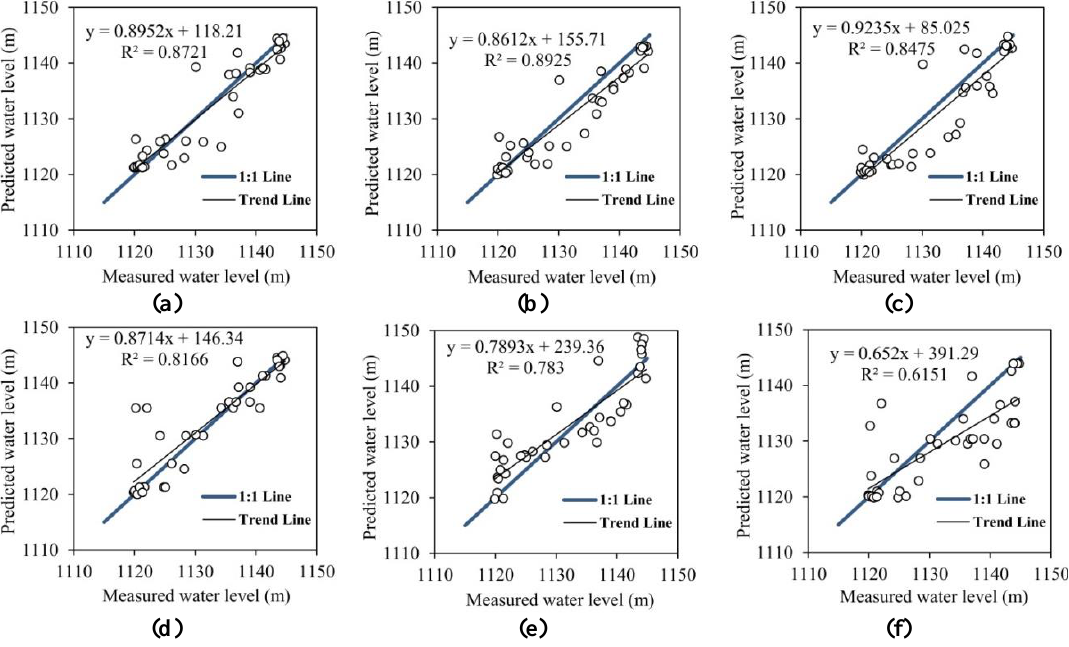
Figure 7- Results obtained from data-driven models in test stage for simulating piezometer 28 level variations; (a) ANN-HS, (b) ANN-PSO, (c) ANN-LM, (d) RDT, (e) MLR, (f)